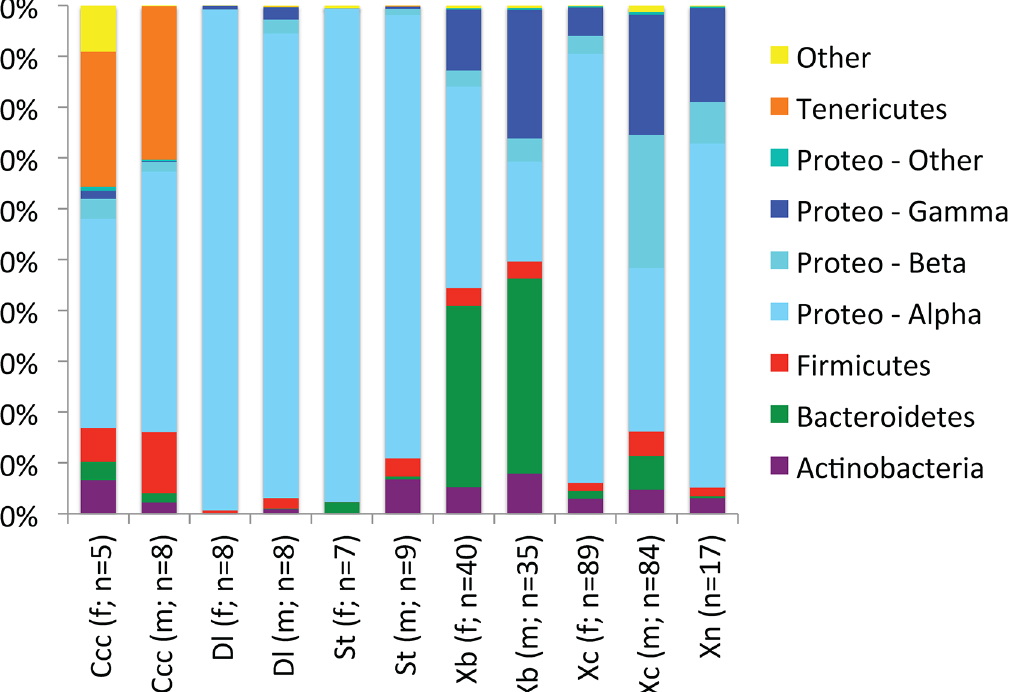
Table 3. Average relative abundances of most common bacterial OTUs detected in Ugandan fleas.